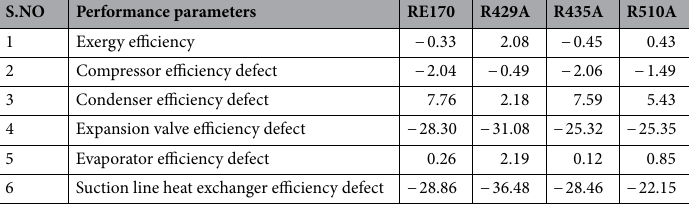
Table 3. Deviation of performance parameters (values are in percentage).